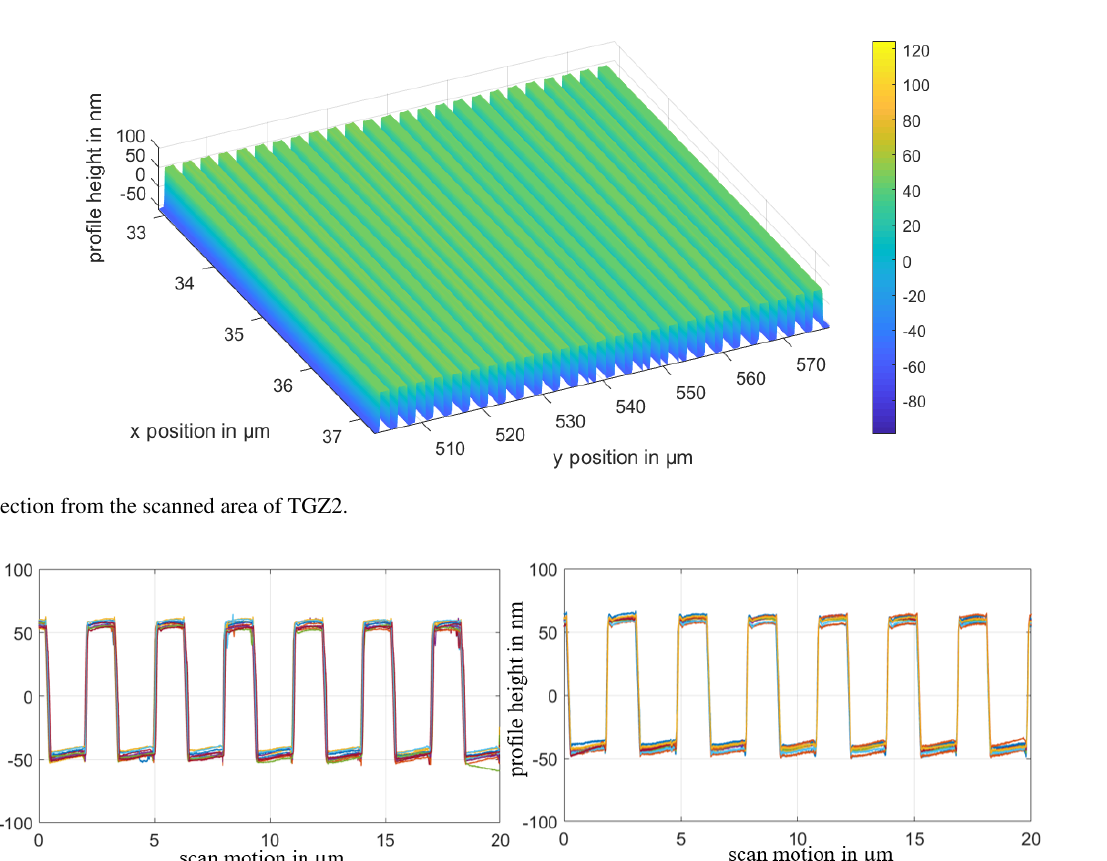
(108 ± 2) nm and a nominal period or pitch of (3 ± 0 . 01)